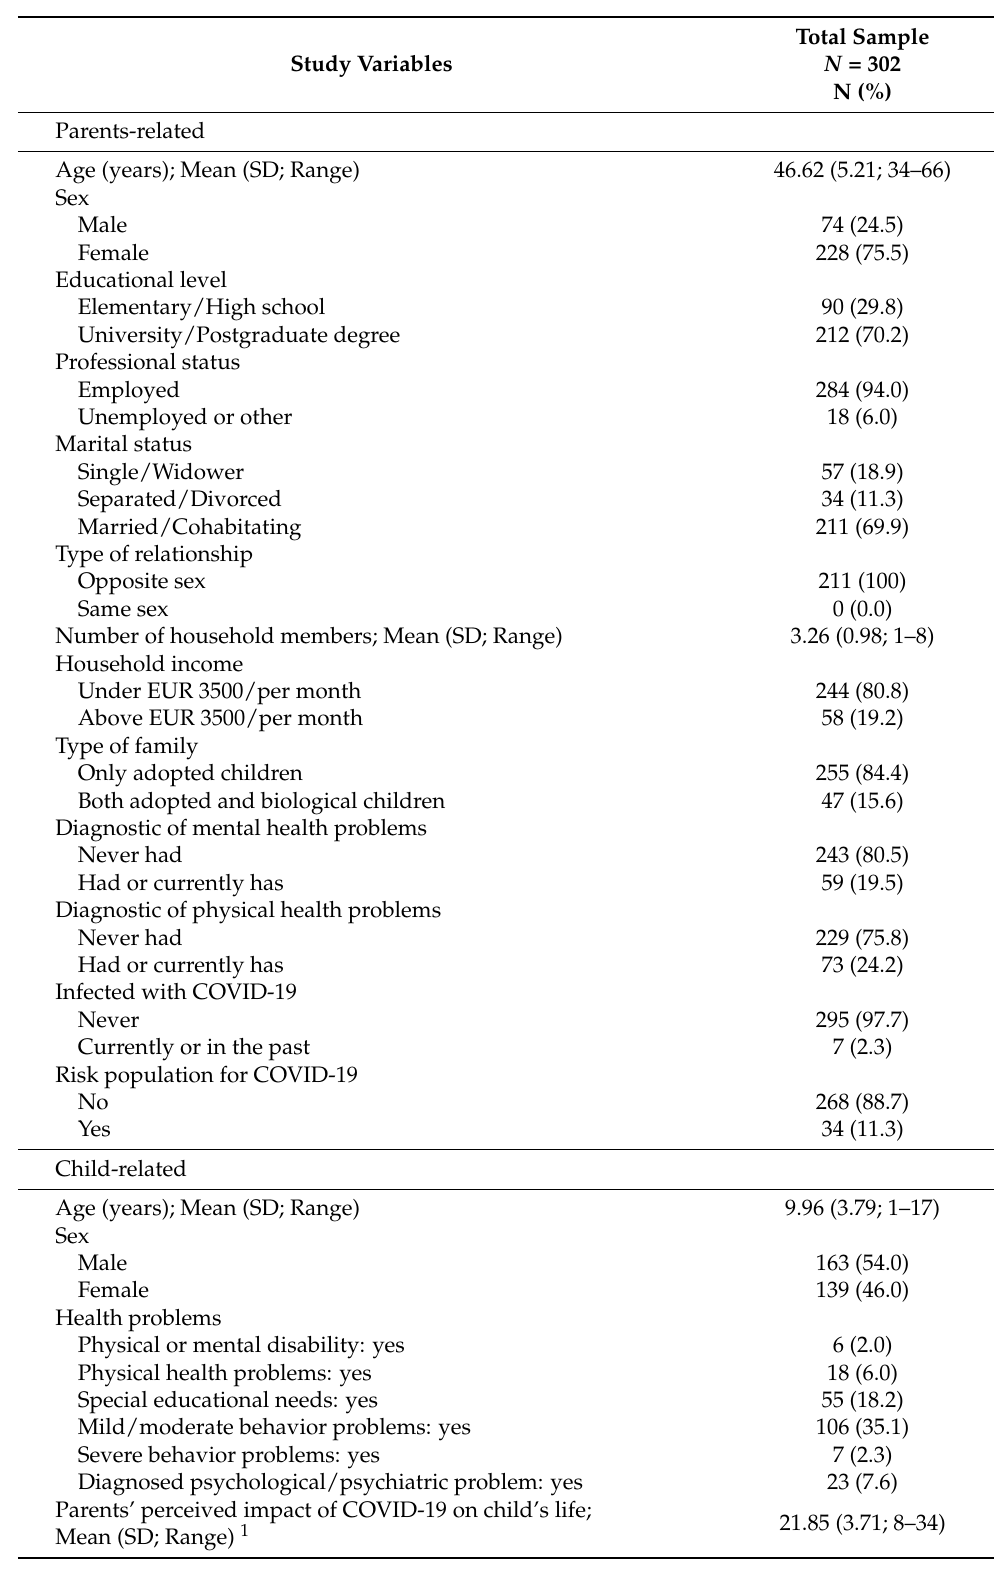
Table 1. Sociodemographic, Health-, Child-, and Adoption-Related Characteristics of the Sample: Descriptive